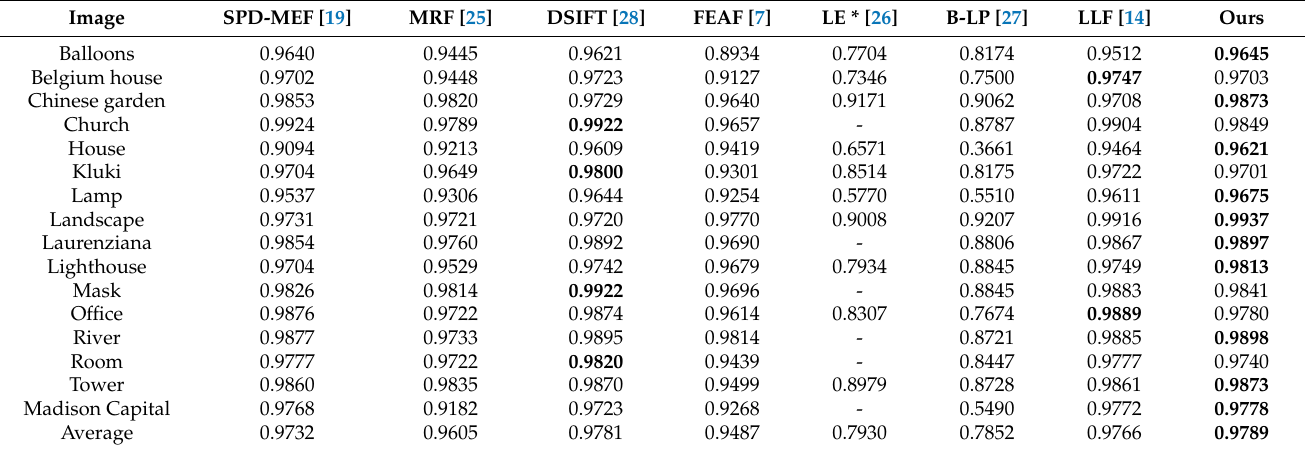
Table 2. Comparison of image quality assessment (IQA) with existing MEF techniques.